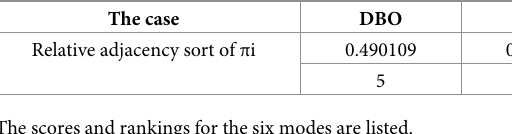
The scores and rankings for the six modes are